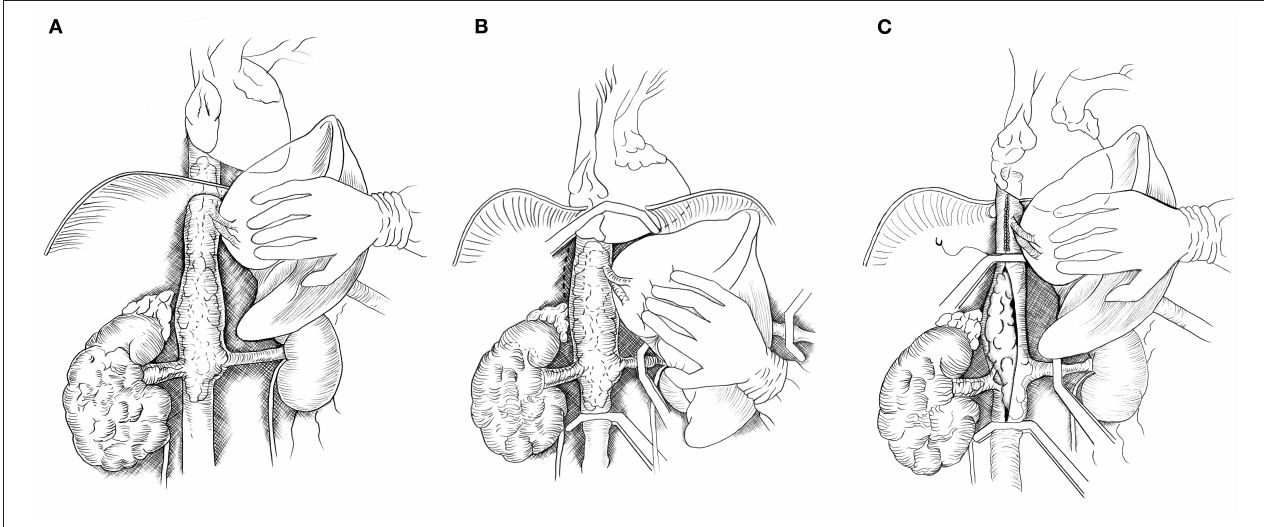
FIGURE 1 | Drawing showing abdominal removal of renal cell carcinoma with level IIId tumor thrombus (TT) (supradiaphragmatic, infraatrial extension). (A) The abdominal inferior vena cava (IVC) is exposed by mobilizing the liver off the retrohepatic IVC. (B) The central tendon of the diaphragm and IVC are dissected off the posterior abdominal wall (dotted lines). The right atrium, distal IVC, porta hepatis and left renal vein are clamped. (C) If the tumor thrombus cannot be milked downward below the major hepatic veins (MHVs), then the tumor thrombus is removed from the intrapericardial IVC to below the MHVs and the upper cava is closed. A vascular clamp is repositioned below the MHVs, and the porta hepatis clamp is released permitting hepatic venous drainage during the removal of the TT and closure or reconstruction of the IVC.